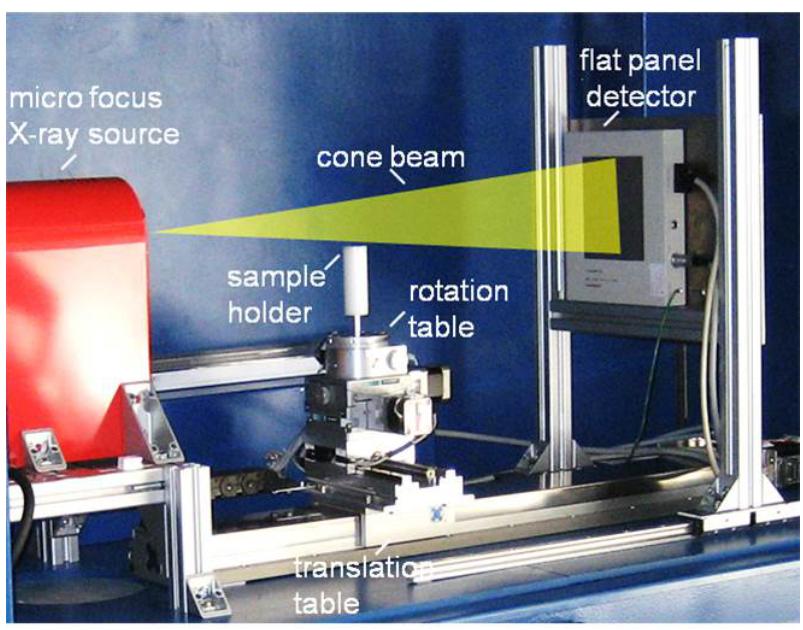
Figure 3: Photo of the MicroCT scanner. The main components are